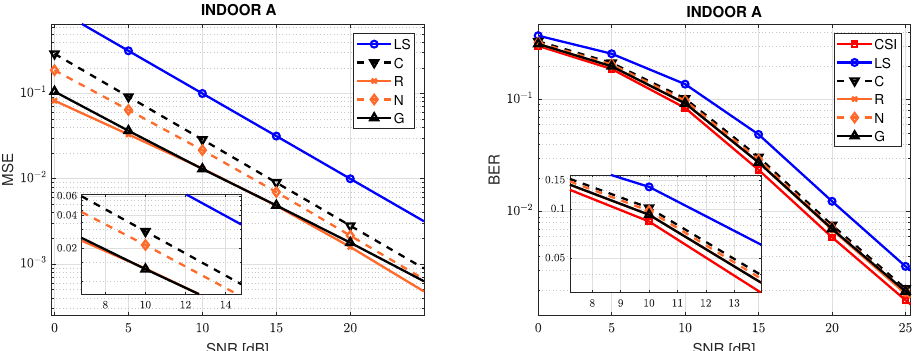
Figure 4. MSE and BER measures for Indoor A channel model.